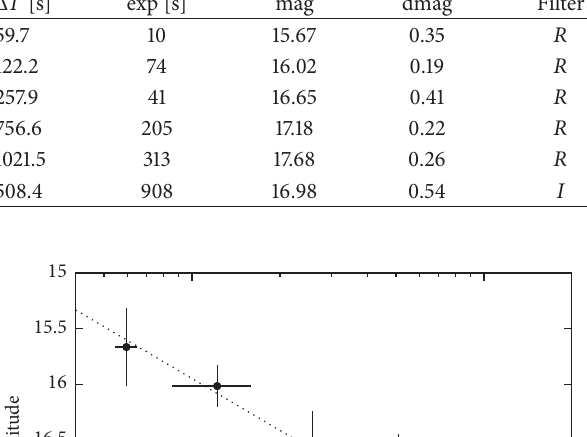
Figure 1: The optical light curve of GRB 050824; the optical light curve represents the behaviour seen by Sollerman et al. [9]. Table 4: GRB 050824: observing log of BOOTES-1B.